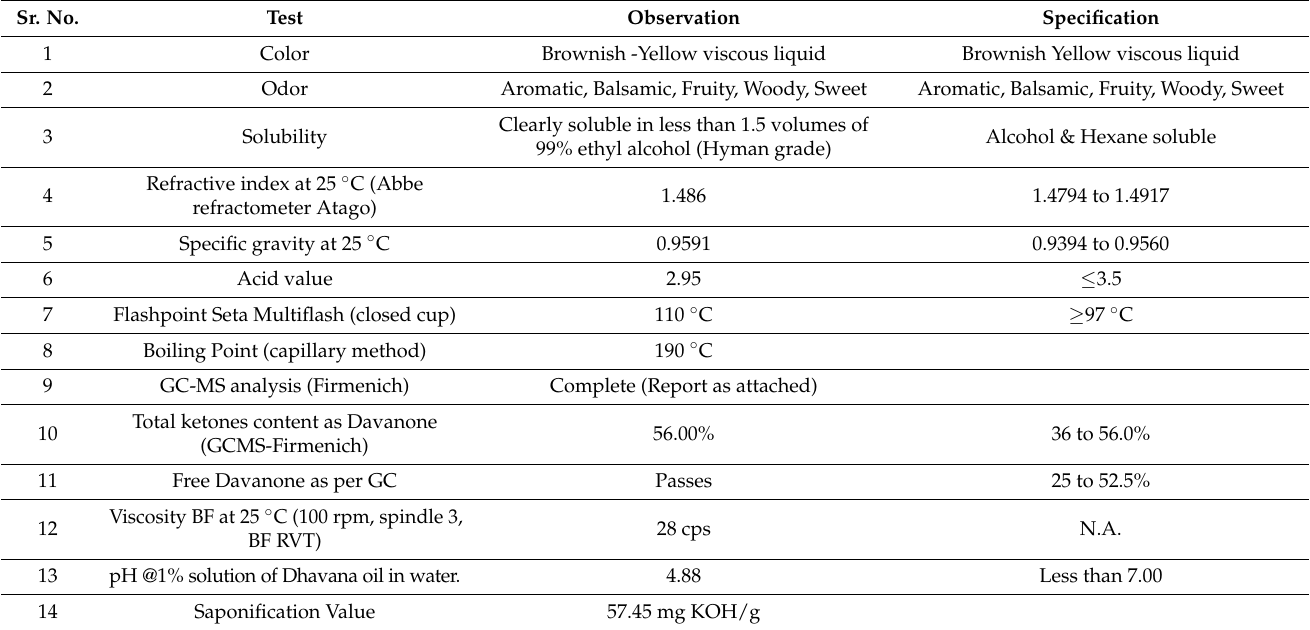
Table 3. Physico-chemical parameters of neat Dhavana